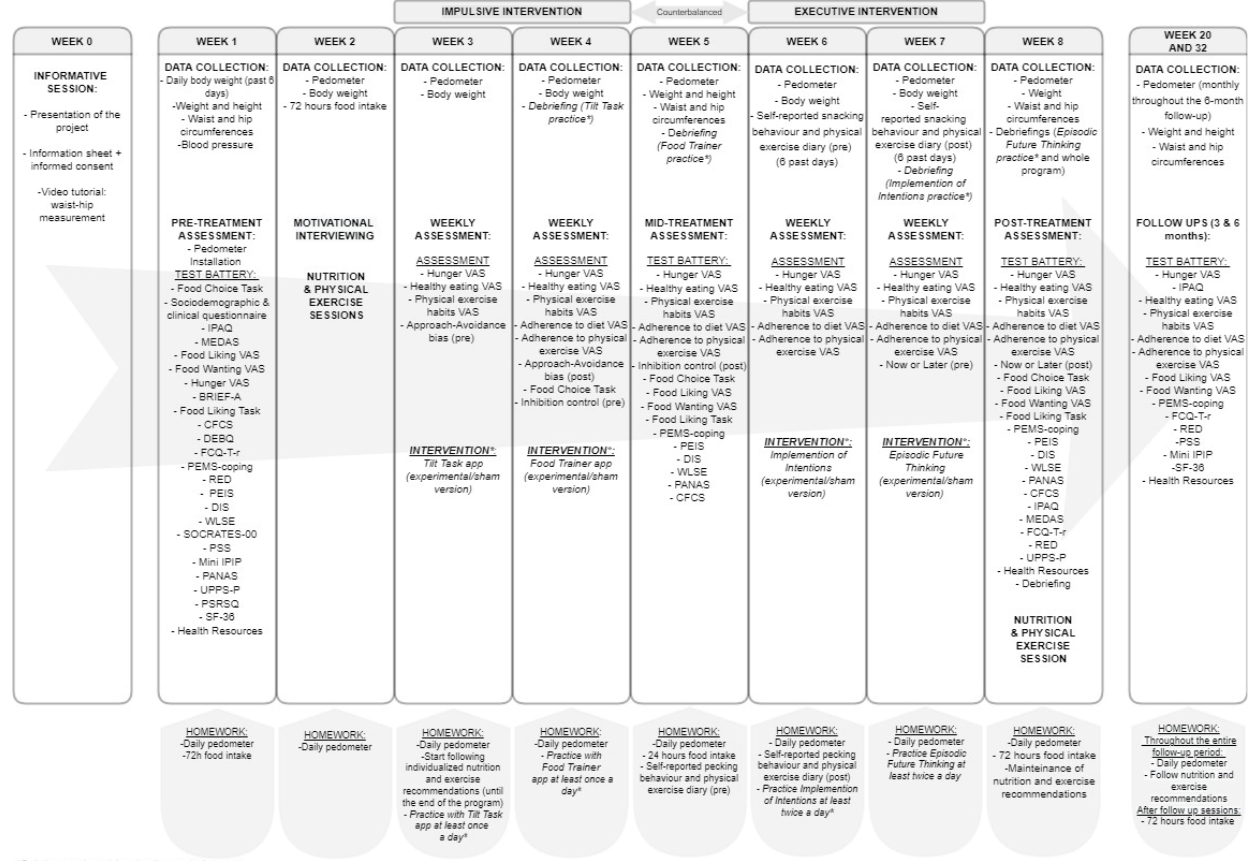
Figure 1. Full schedule of assessments and interventions.